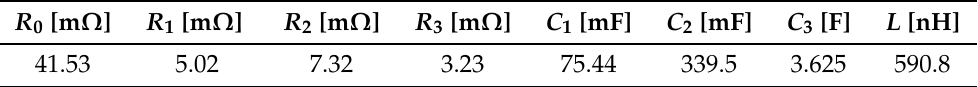
Table 1. Battery cell parameters of LG Chem CR18650 C2